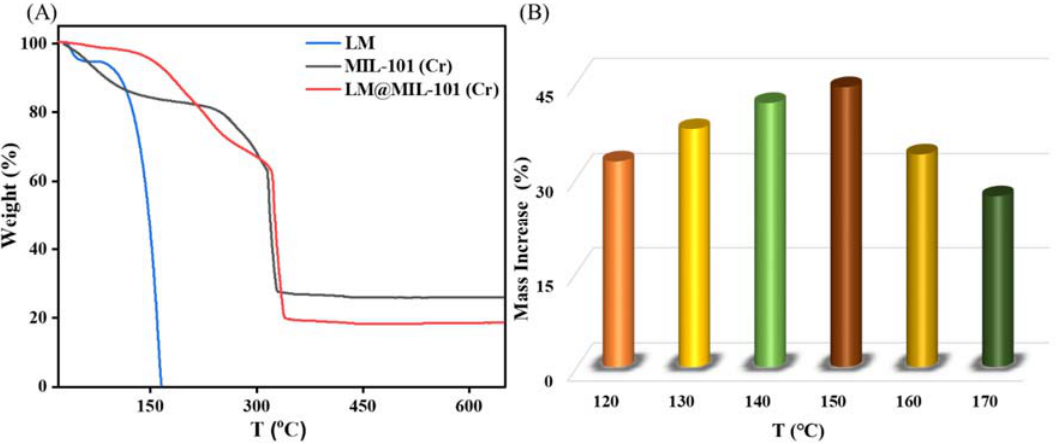
Figure 3. ( A ) Thermal stability of LM, MIL ‐ 101 (Cr) and LM@MIL ‐ 101 (Cr); ( B ) adsorption of LM on MIL ‐ 101 (Cr) at different temperatures.